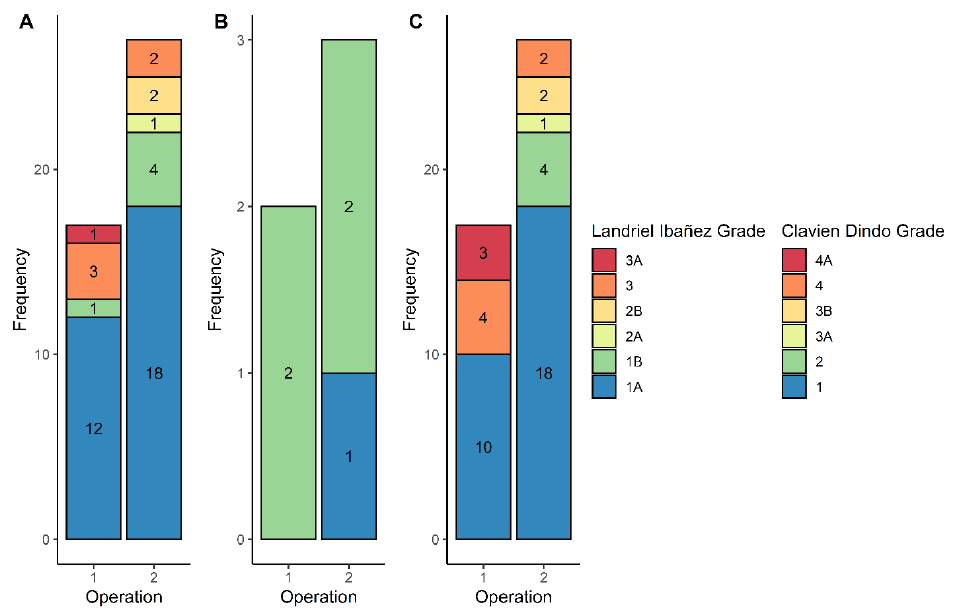
Figure 3. Stacked bar charts demonstrating post-operative complications graded according to Landriel-Ibañez classification ( A and B ) and Clavien-Dindo classification ( C ). The Landriel-Ibañez classification includes both surgical ( A ) and medical ( B ) complications. Frequency of each grade is demonstrated within the bars. Table 3. Post-operative complications identified after a first and second operation. Frequency of complications may be greater than the total of the category (e.g., surgical, medical, neurological complications) due to patients having had multiple complications.